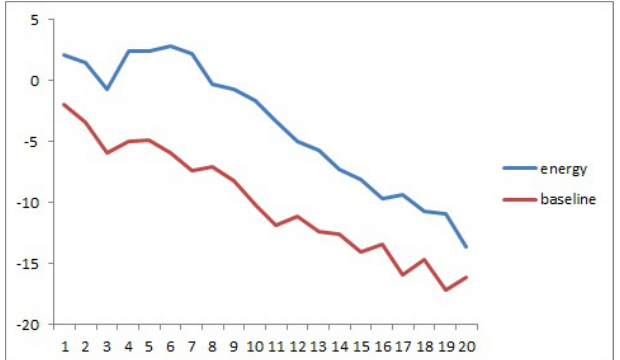
Figure A10. Comparison for asset prices.